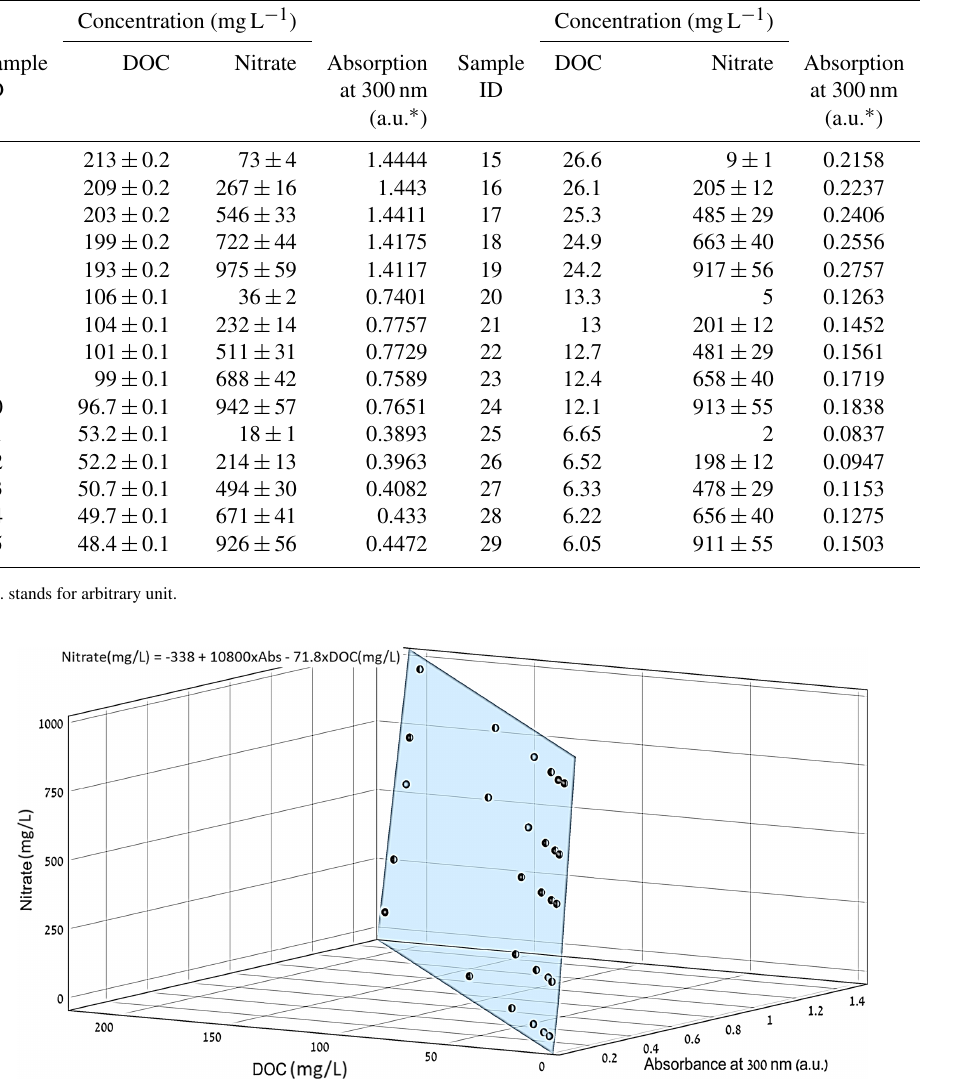
Figure 2. 3D projection of the nitrate concentration as a function of the DOC concentration and absorbance at 300nm for water samples obtained from the conventional greenhouse.